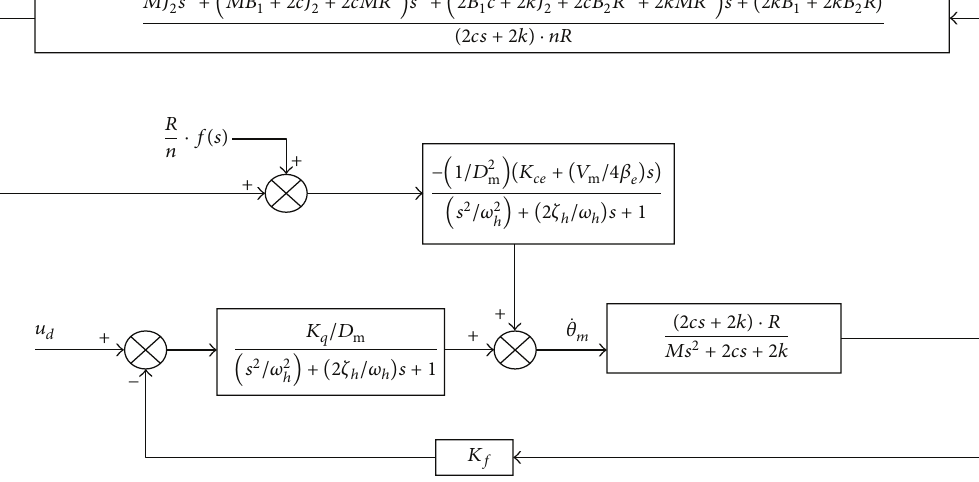
Figure 7: The transfer function diagram of the underwater vehicle speed control